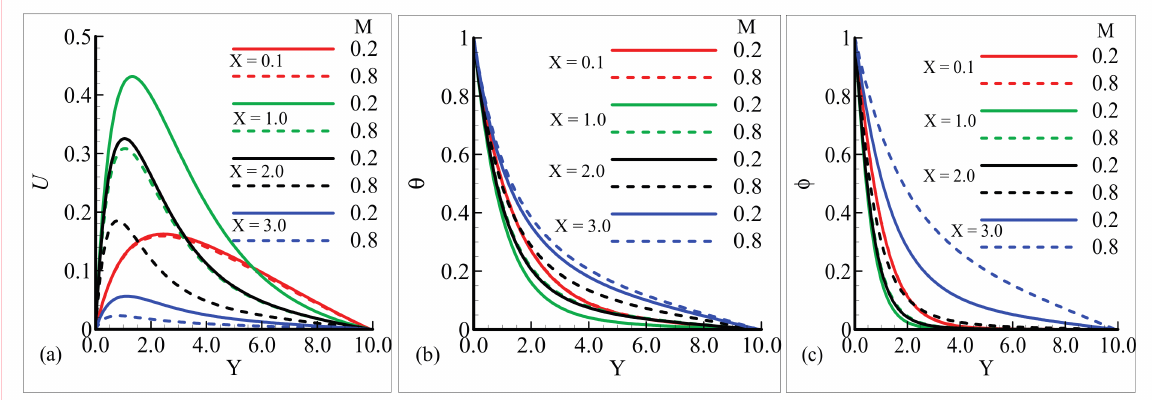
Figure 6. Physical e ff ects on quantities ( a ) U , ( b ) θ , and ( c ) ϕ versus M, when Nt = 0.02, Nb = 0.4, Pr = 7.0, Sc = 10, Q =